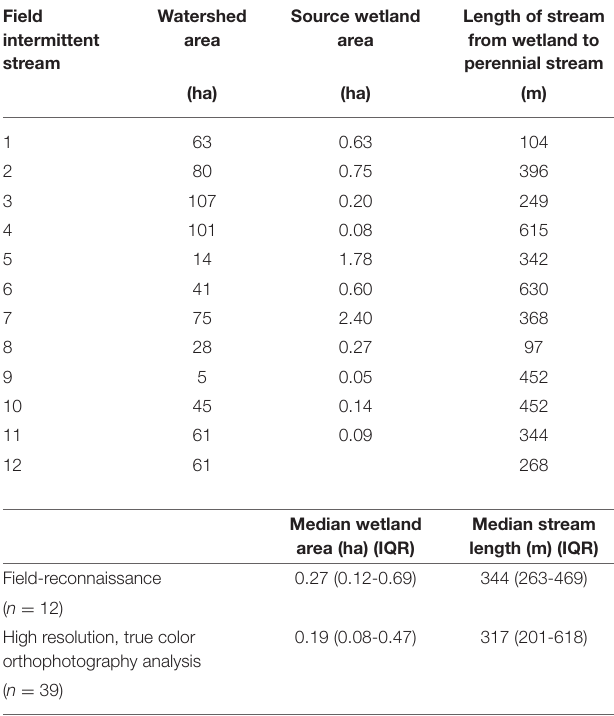
TABLE 1 | Intermittent stream watershed area, source wetland area, and the length of intermittent stream from its source wetland to the perennial